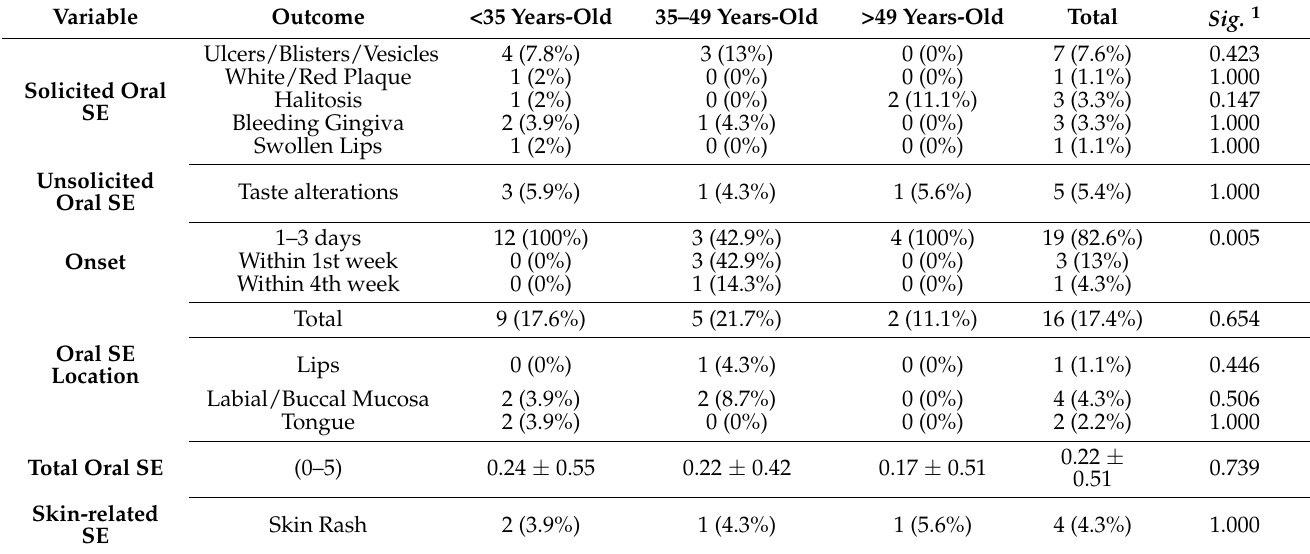
Table 4. Oral and skin-related side effects of AstraZeneca COVID-19 vaccine among European healthcare workers, February– March 2021.